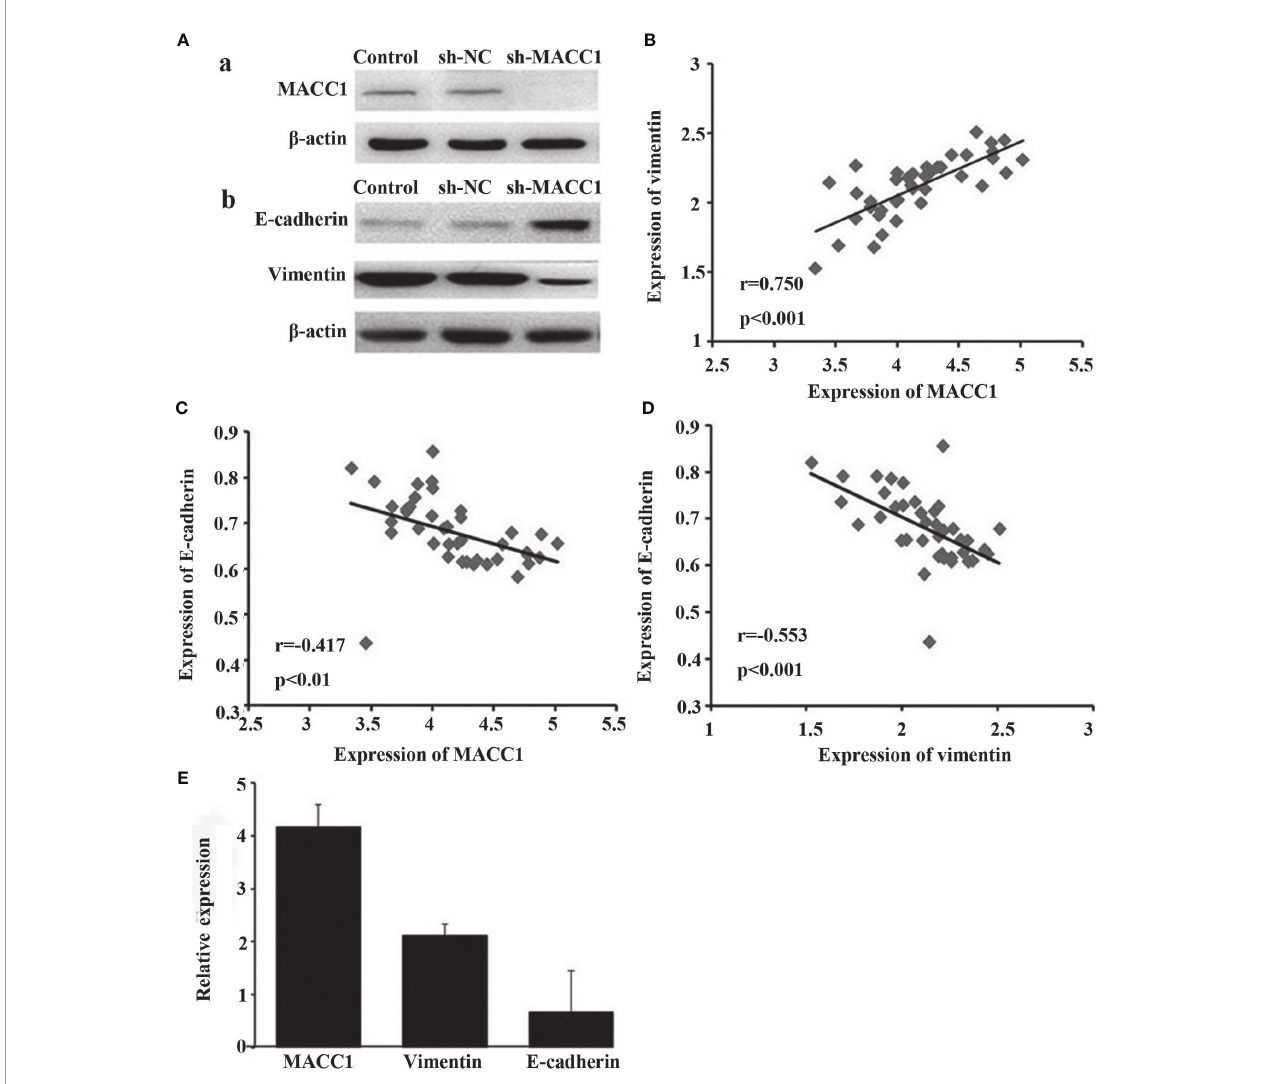
FIGURE 2 | Knockdown of MACC1 inhibits EMT in HNE-1 cells. HNE-1 cells were transfected with sh-MACC1 or sh-NC or were not transfected with shRNA (control). (A, a) Western blot showing MACC1 shRNA knockdown in HNE-1 cells. (A, b) Western blot showing E-cadherin and vimentin expression in sh-MACC1- transfected HNE-1 cells. (B) Correlation analysis of MACC1 and vimentin levels (r=0.750, p<0.001). (C) Correlation analysis of MACC1 and E-cadherin levels (r=- 0.417, p<0.01). (D) Correlation analysis of vimentin and E-cadherin levels (r=-0.553, p<0.001). (E) Relative expression of MACC1,vimentin and E-cadherin